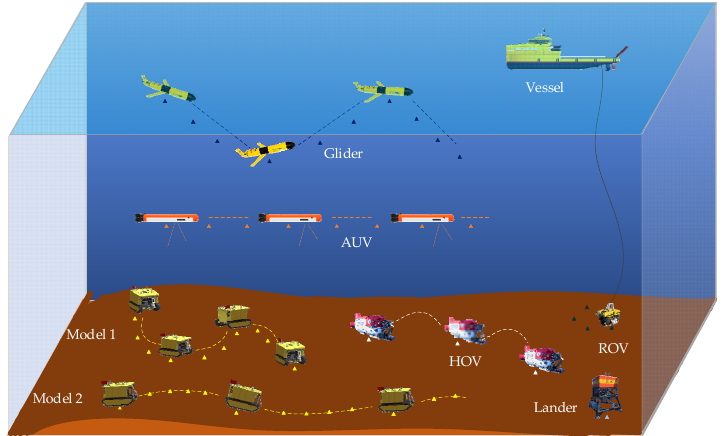
Figure 1. Schematic sketch of the demonstration mission. (Note: Sampling locations are represented by small triangles in the figure)